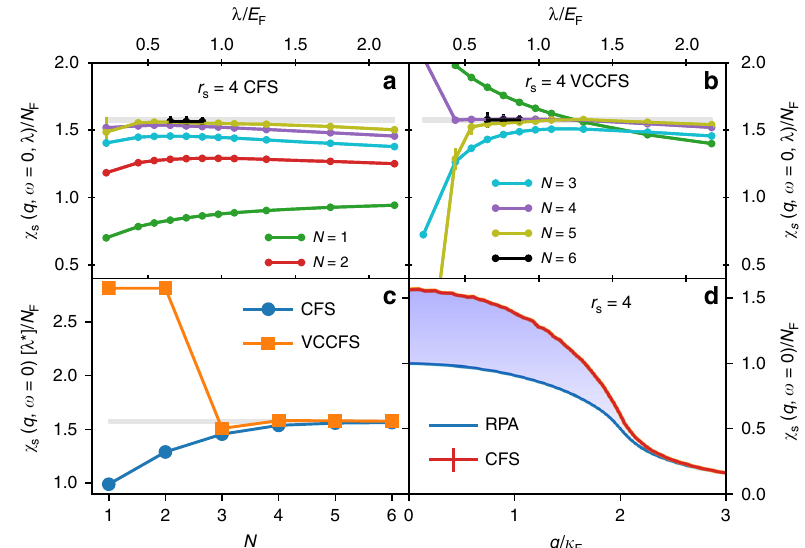
Þ . The optimization of χ q = 0, ω = 0) versus the screening parameter s ( s ¼ ð 3 Þ 2 = 3 = ð 2 π r Þ , and the Fermi energy F s 2 π λ * appears, which is = E ¼ 0 : 75 in CFS scheme, along with comparison to random phase approximation (RPA), which N ¼ 6 F